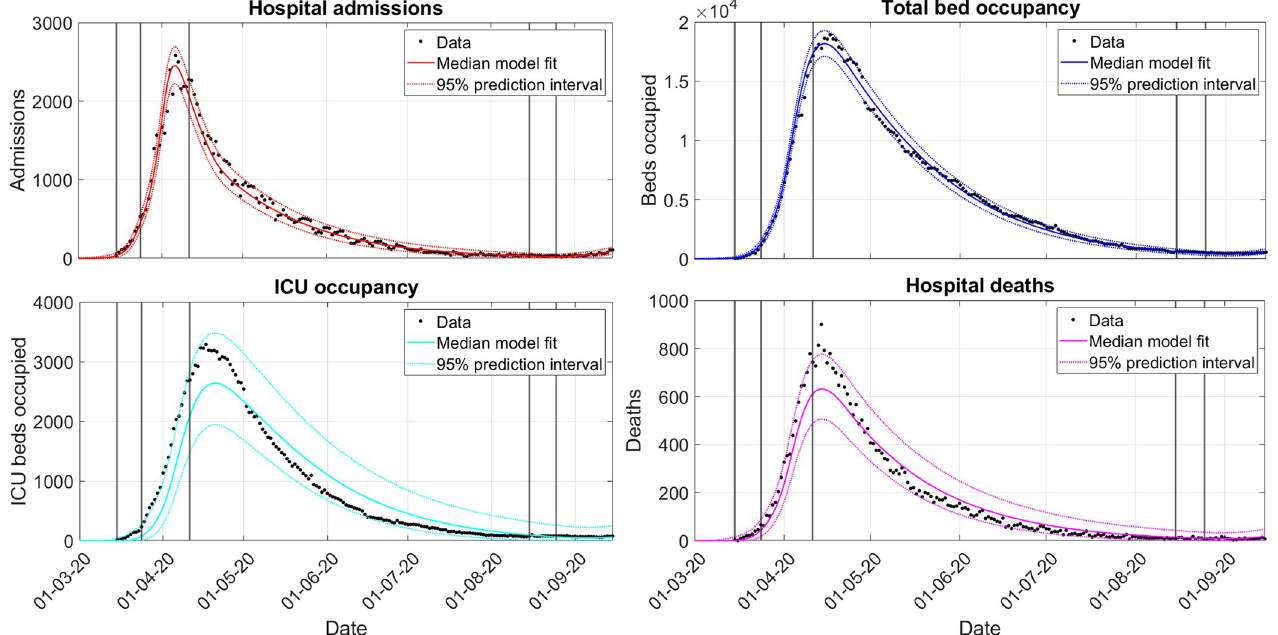
Fig 2. First-wave model fit to admissions (red), beds (blue), ICU beds (cyan) and deaths (magenta). Vertical lines indicate when transmission rate changes are added to EpiBeds (see Section SM.1.3.3 in S1 Supplementary Material). Note that there is a delay between transmission changing in the community and its effect being observed in the hospital data, so visual inflections in the model trend occur after the transmission change point. The 90% prediction interval was calculated by generating, for each parameter posterior sample, a new potential realisation of the data and then taking the 5 and 95 quantiles of the set of realised data at each time point. All dates are given as